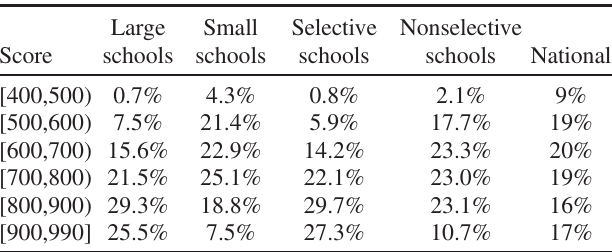
TABLE III. Distribution of applicants scoring in each physics GRE range by size of institution. ETS only publishes overall score distributions and hence, we cannot report national scores from only domestic